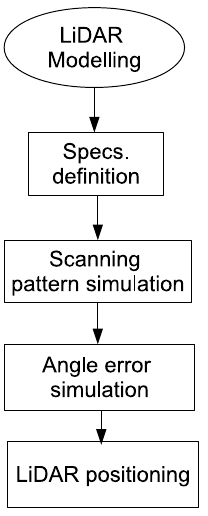
Figure 4. LiDAR modelling workflow